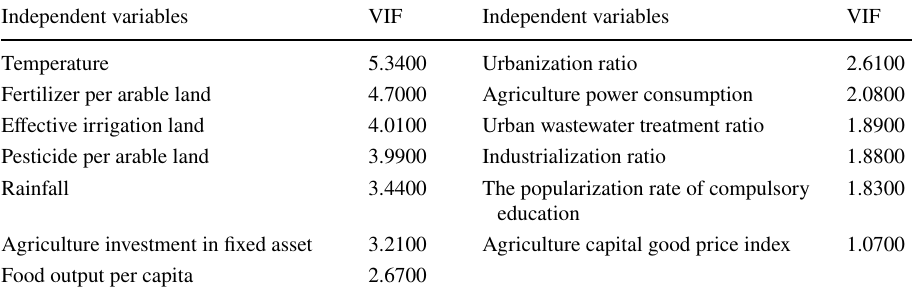
Table 2 VIF test